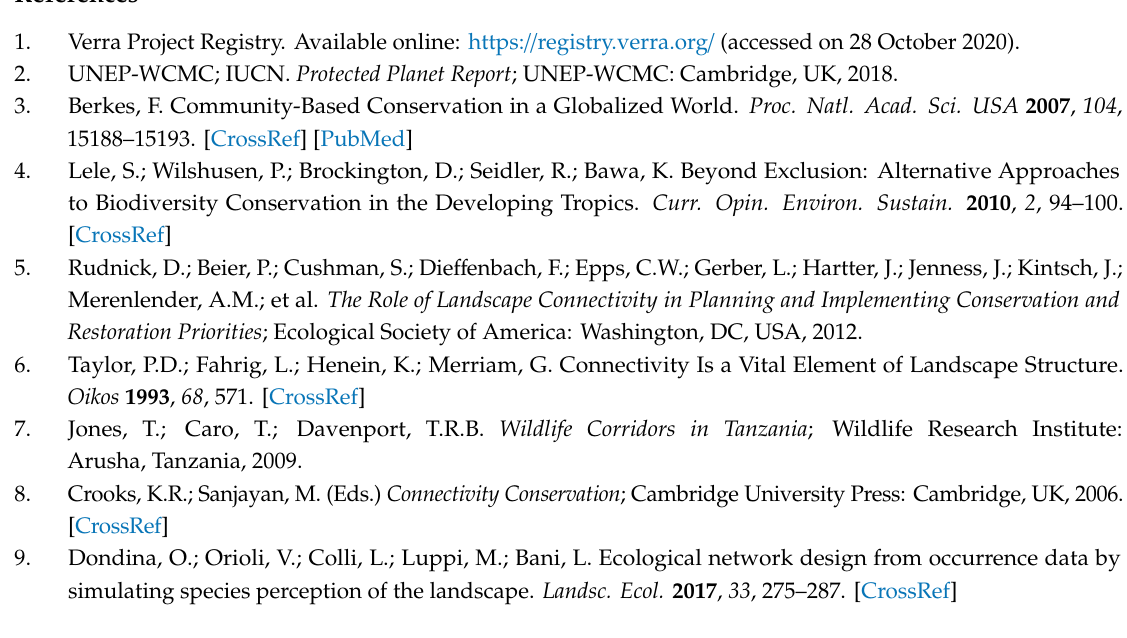
Figure S1: Locations of the occurrence points used in the final habitat suitability model, Table S1: Predictive accuracy and standard deviation (SD) of the 5 replicates for the 3 algorithms t, Figure S2: Response curves derived by the ensemble